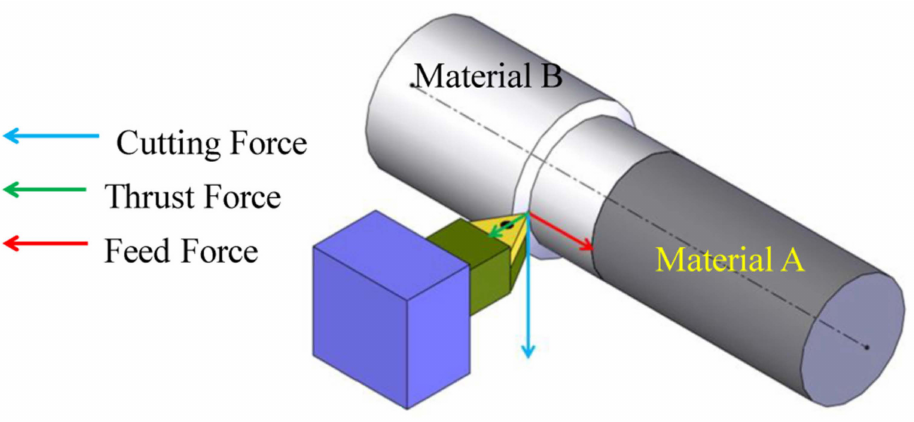
Figure 1. Feature of electrical discharge machining of bimetallic material with a blade